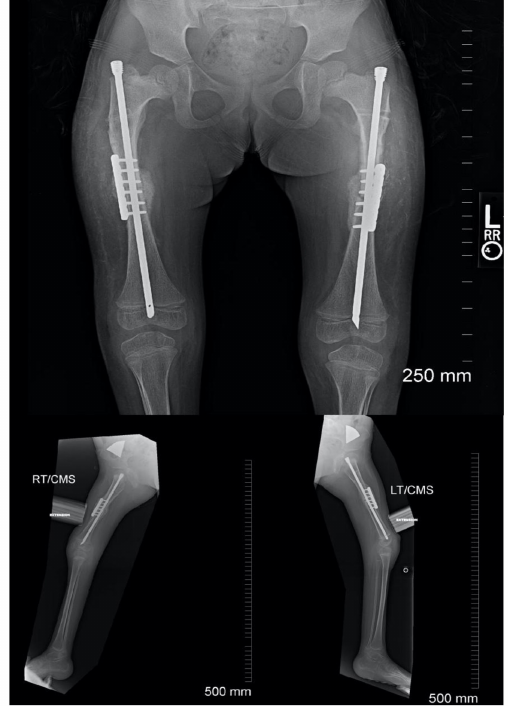
Figure 9. Post-operative follow-up demonstrating rod and plate construct as well as healing of